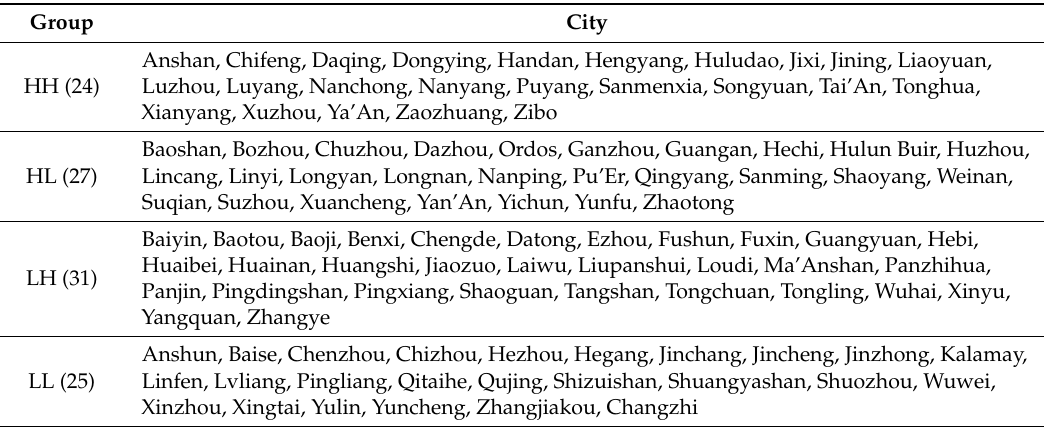
Table 6. Classification of resource-based cities based on static efficiency and dynamic productivity change.